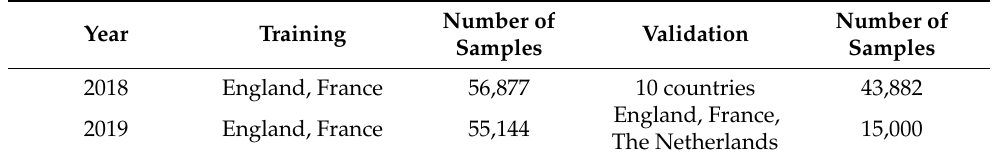
Figure 3. Temporal profiles of ( a ) NDVI, ( b ) NDYI, ( c ) REP, ( d ) nir, ( e ) swir1, ( f ) swir2, ( g ) red edge 1, ( h ) red edge 2, and ( i ) red edge 3, for major crop and non-agricultural land cover types in the European Union. Lines depict the mean values of different crop and non-agricultural land cover types. Shaded areas depict error bars with one positive/nega- tive standard deviation of maize, rapeseed, and winter and spring Triticeae crops. Table 2. Summary of training and point-based